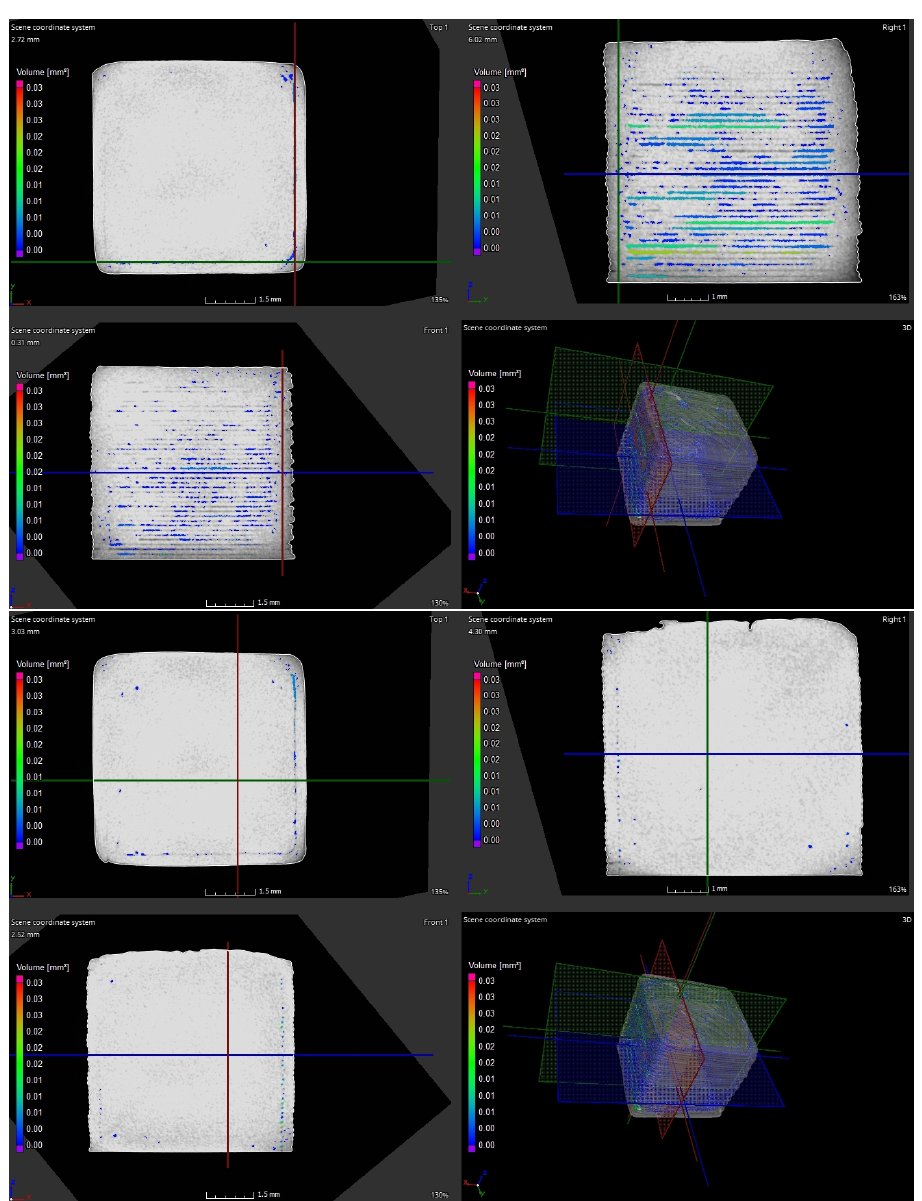
Figure 8. Data from CT ZEISS METROTOM 1500 of sample with 100% infill. Porosity in the area of perimeters ( up ). Porosity of the inner area of the part ( down